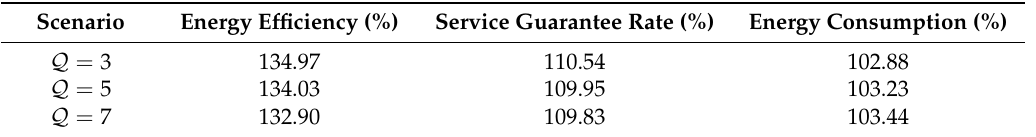
Table 11. Optimization of energy efficiency.